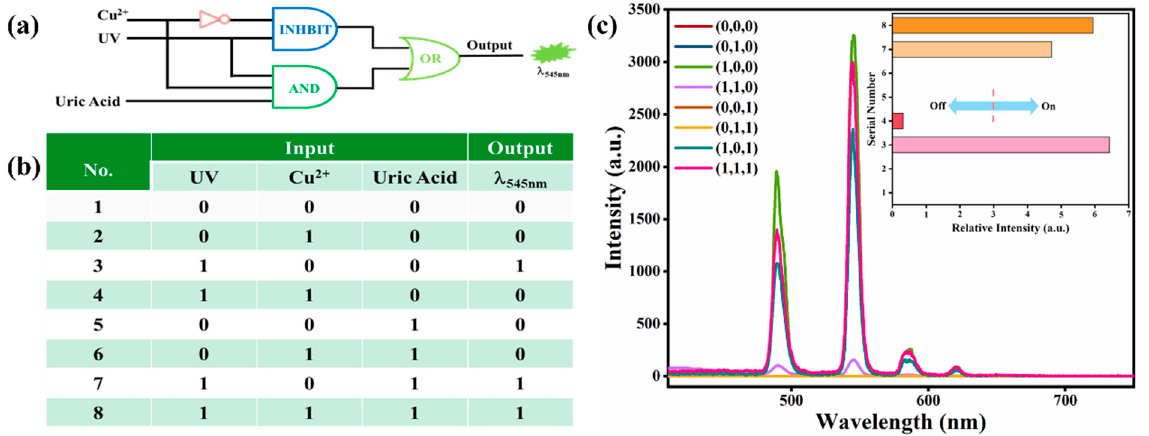
Figure 5. ( a ) Electronic equivalent circuitry of the logic gate; ( b ) The truth table of the logic gate; ( c ) Emission spectra of the logic gates (the inset is the relative emission intensity at 545